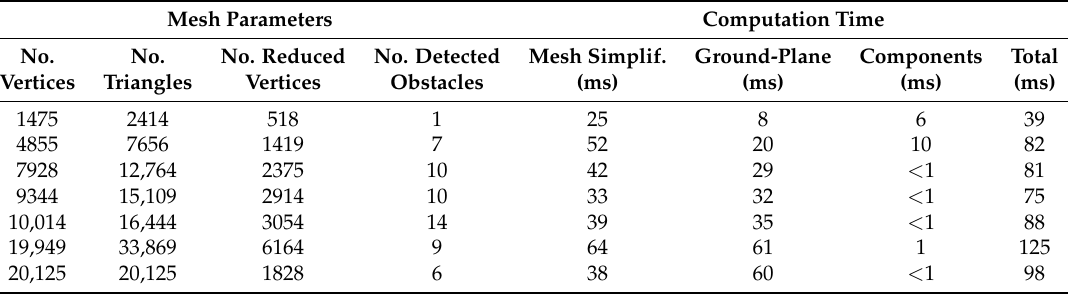
Table 1. Measured computation times for scene-processing tasks, namely: mesh simplification, ground-plane extraction and objects detection (via connected components retrieval). The acquisition is sequential: the number of mesh vertices (first column) grows as the environment is being explored by the Head-Mounted Display (HDM). Thanks to mesh simplification, the overall computation time remains stable on average as the mesh size